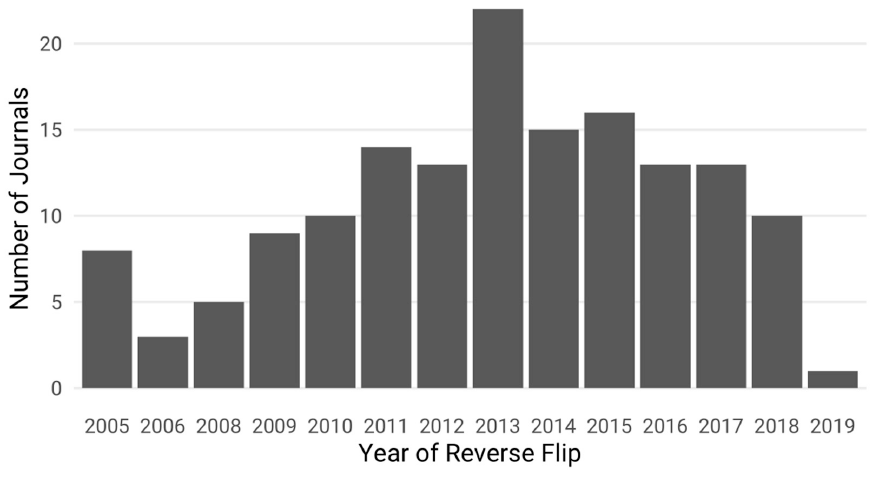
Figure 3. The number of journals that reverse-flipped from fully open access (OA) to a subscription- based access model (incl. hybrid OA) per year. access model (incl. hybrid OA) per